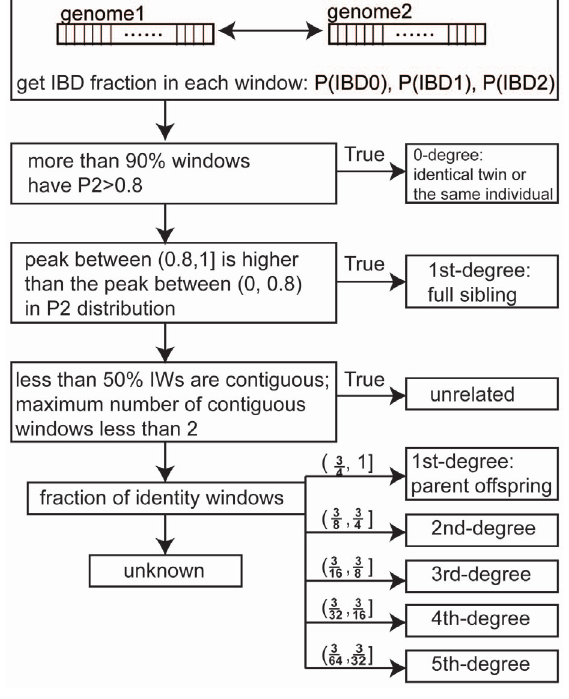
Figure 3. GRAB Workflow.